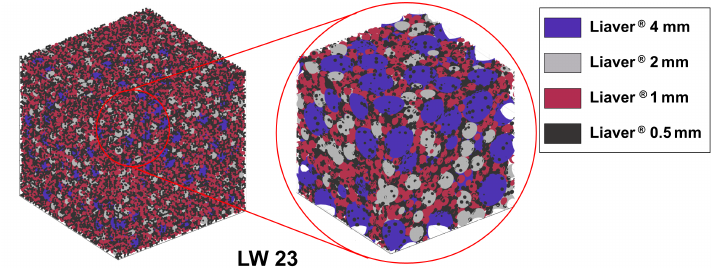
(cid:13) particles in each specimen is about 73%.).